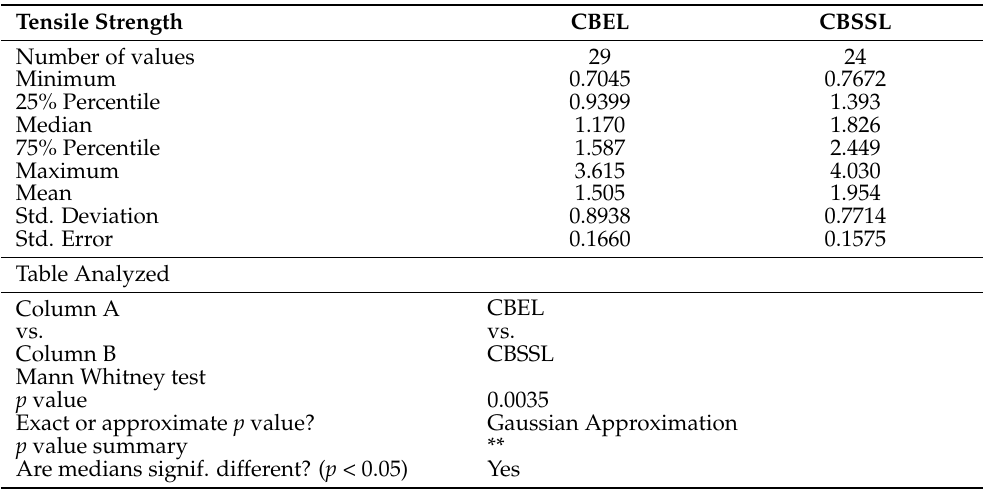
Table A9. Tensile strength: conventional system elastic ligatures vs. stainless steel ligatures. Tensile Strength Number of values